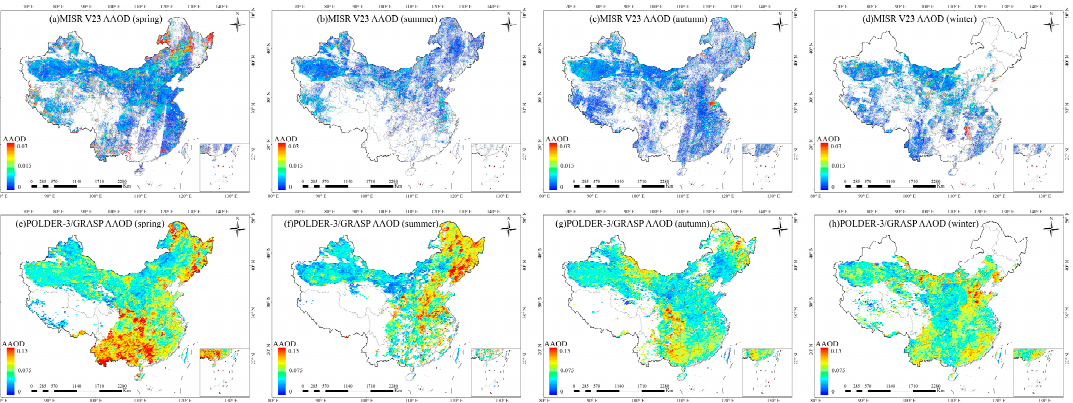
Figure 9. Distributions of seasonal mean AAOD in 2012 from MISR V23 at 558 nm (( a ) spring; ( b ) summer; ( c ) autumn; ( d ) winter) and POLDER-3/GRASP at 565 nm (( e ) spring; ( f ) summer; ( g ) autumn; ( h ) winter).